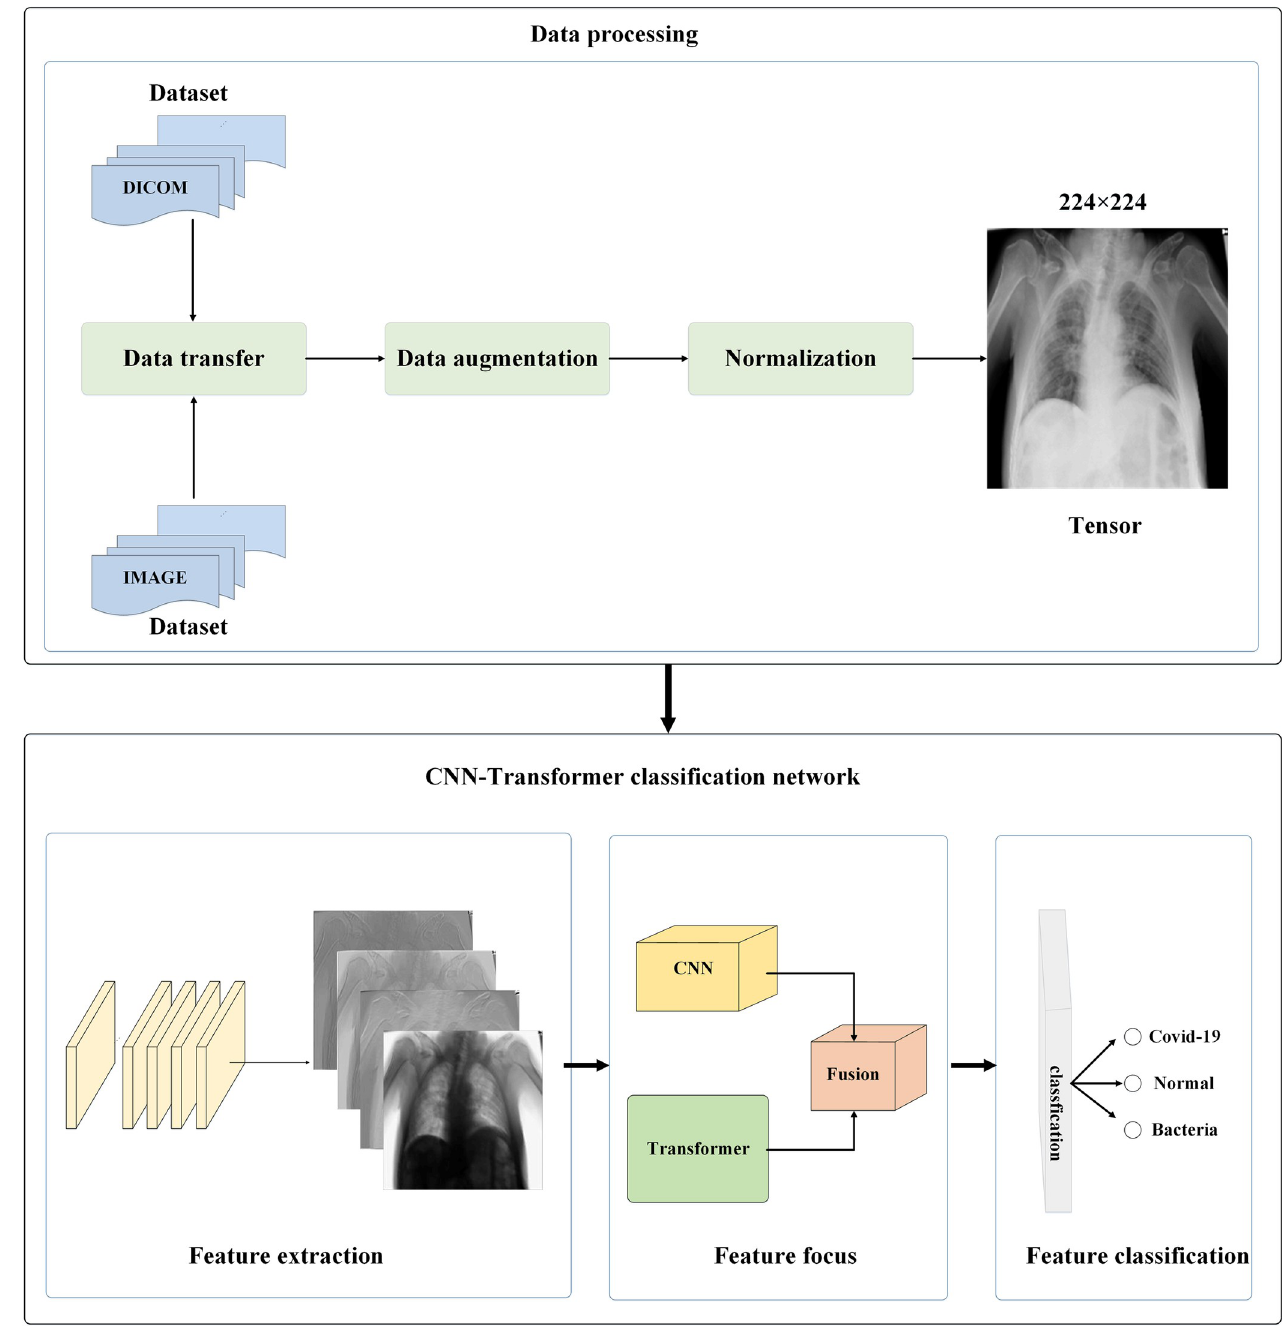
Fig 1. Overview of image classification method based on CNN and